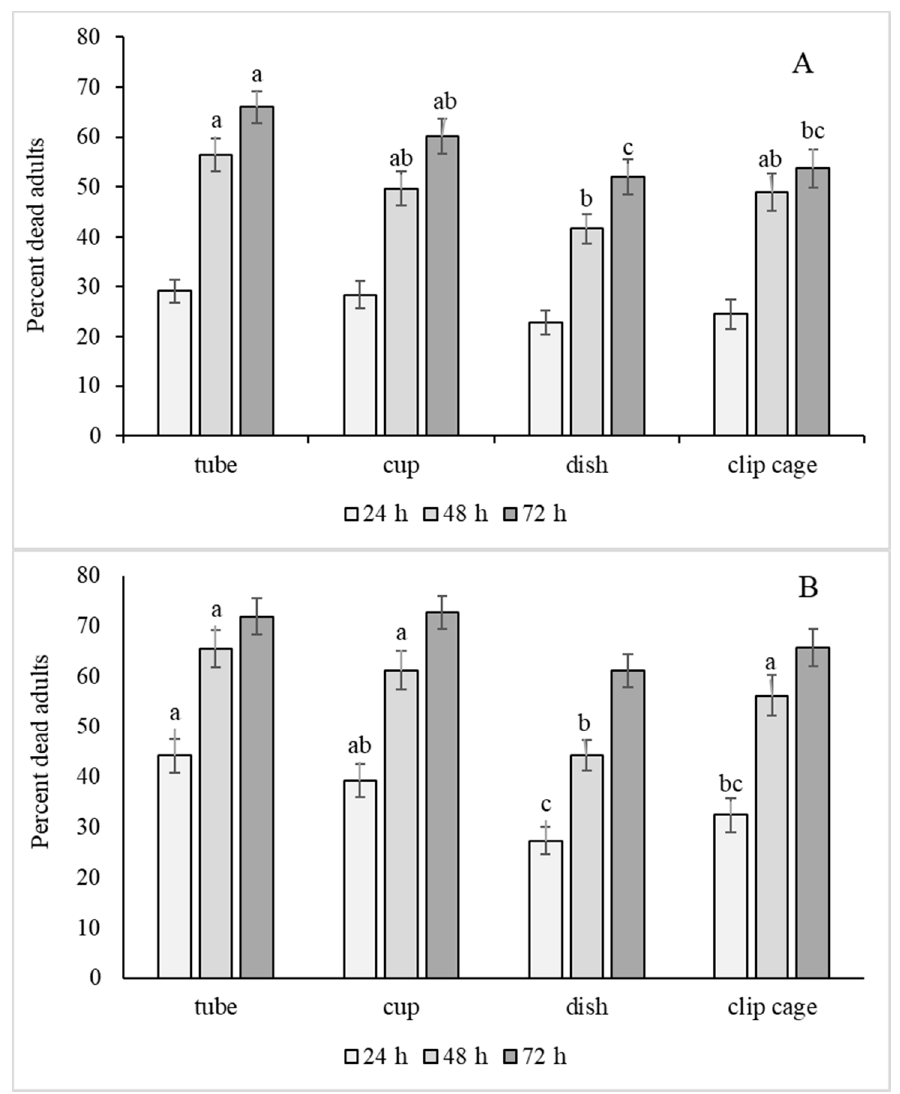
Figure 6. Mean % adult mortality (±se) of Florida ( A ) and Georgia ( B ) populations for tube, cup, petri dish, and clip cage methods at 24, 48 and 72 h. Means within hour reading labeled with the same lower case letter or no letter were not significantly different (LSD, p < 0.05).